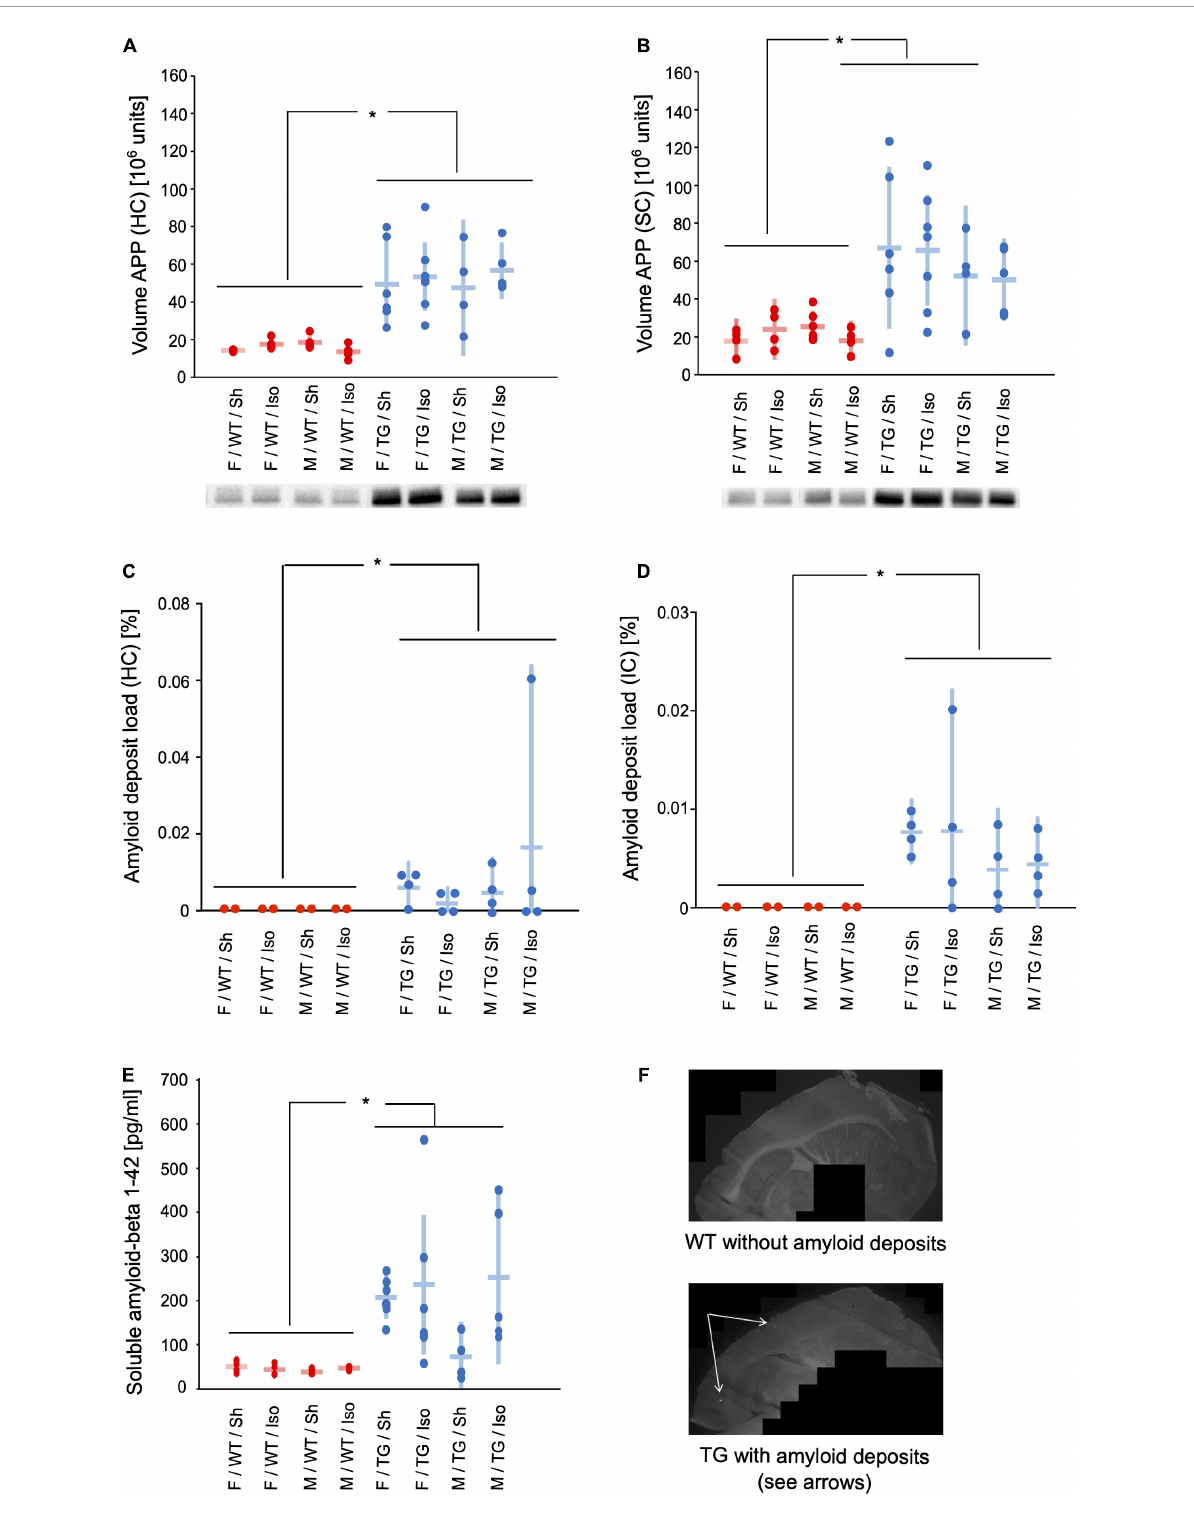
FIGURE4 Volume of amyloid precursor protein (APP) in hippocampus (HC) (A) and sensory cortex (B) [10 6 units] and representative western-blot bands. Amyloid deposit load in hippocampus (HC) (C) and isocortex (IC) (D) [% of total area]. Soluble amyloid beta 1–42 (E) [pg/ml]. Mean and 95%-confidence interval sorted by group. Representative images of methoxy staining (10 × magnification) (F) . APP in HC and SC, amyloid deposit load in HC and IC, and soluble amyloid beta were increased in Tg2576 compared to WT. F, female; M, male; WT, wildtype (red); TG, Tg2576 (blue); Sh, sham procedure; Iso, isoflurane anesthesia. * p <